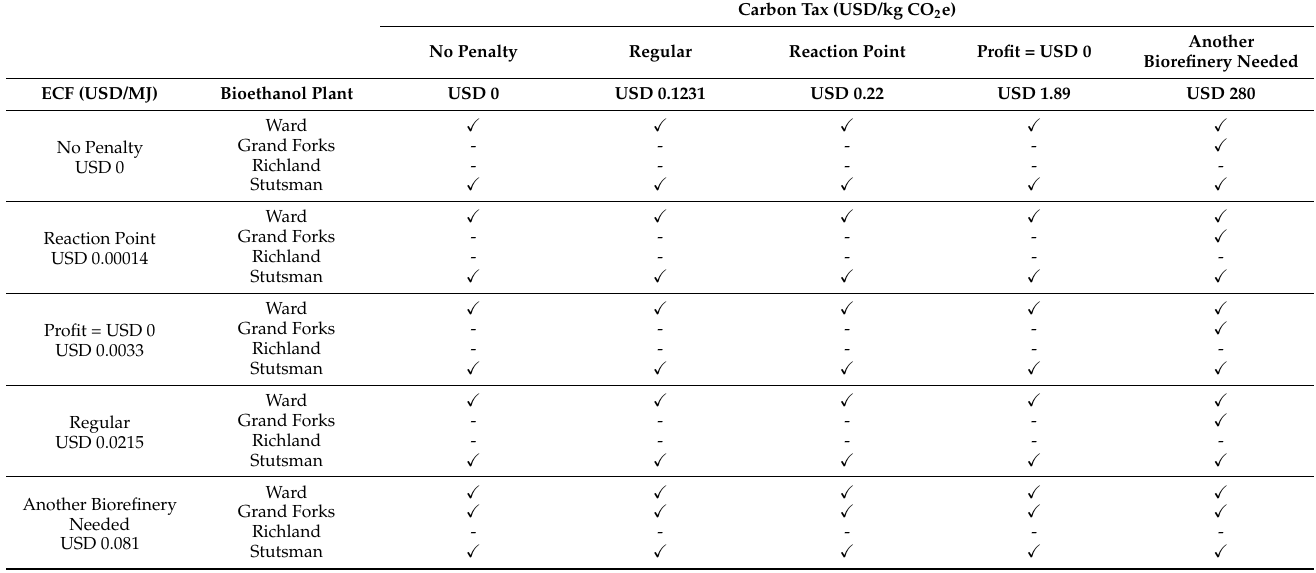
Table 10. Impact of different ECFs and carbon taxes on bioethanol plant land allocation at 300 MGPY demand